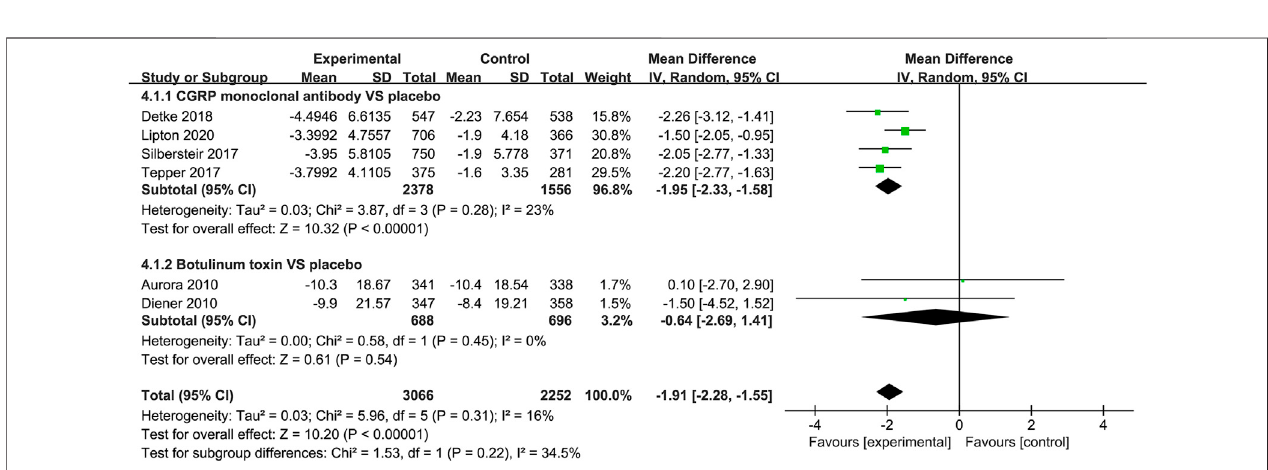
FIGURE 6 | Pooled weighted mean differences of change in frequency of acute analgesics intake in the treatment group compared with placebo; diamond indicates the estimated relative risk with 95% con fi dence interval for the pooled patients.